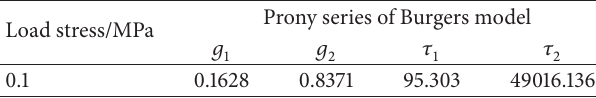
Table 2: The Prony series of Burgers model parameters.